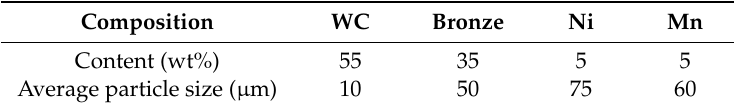
Table 1. Composition of initial